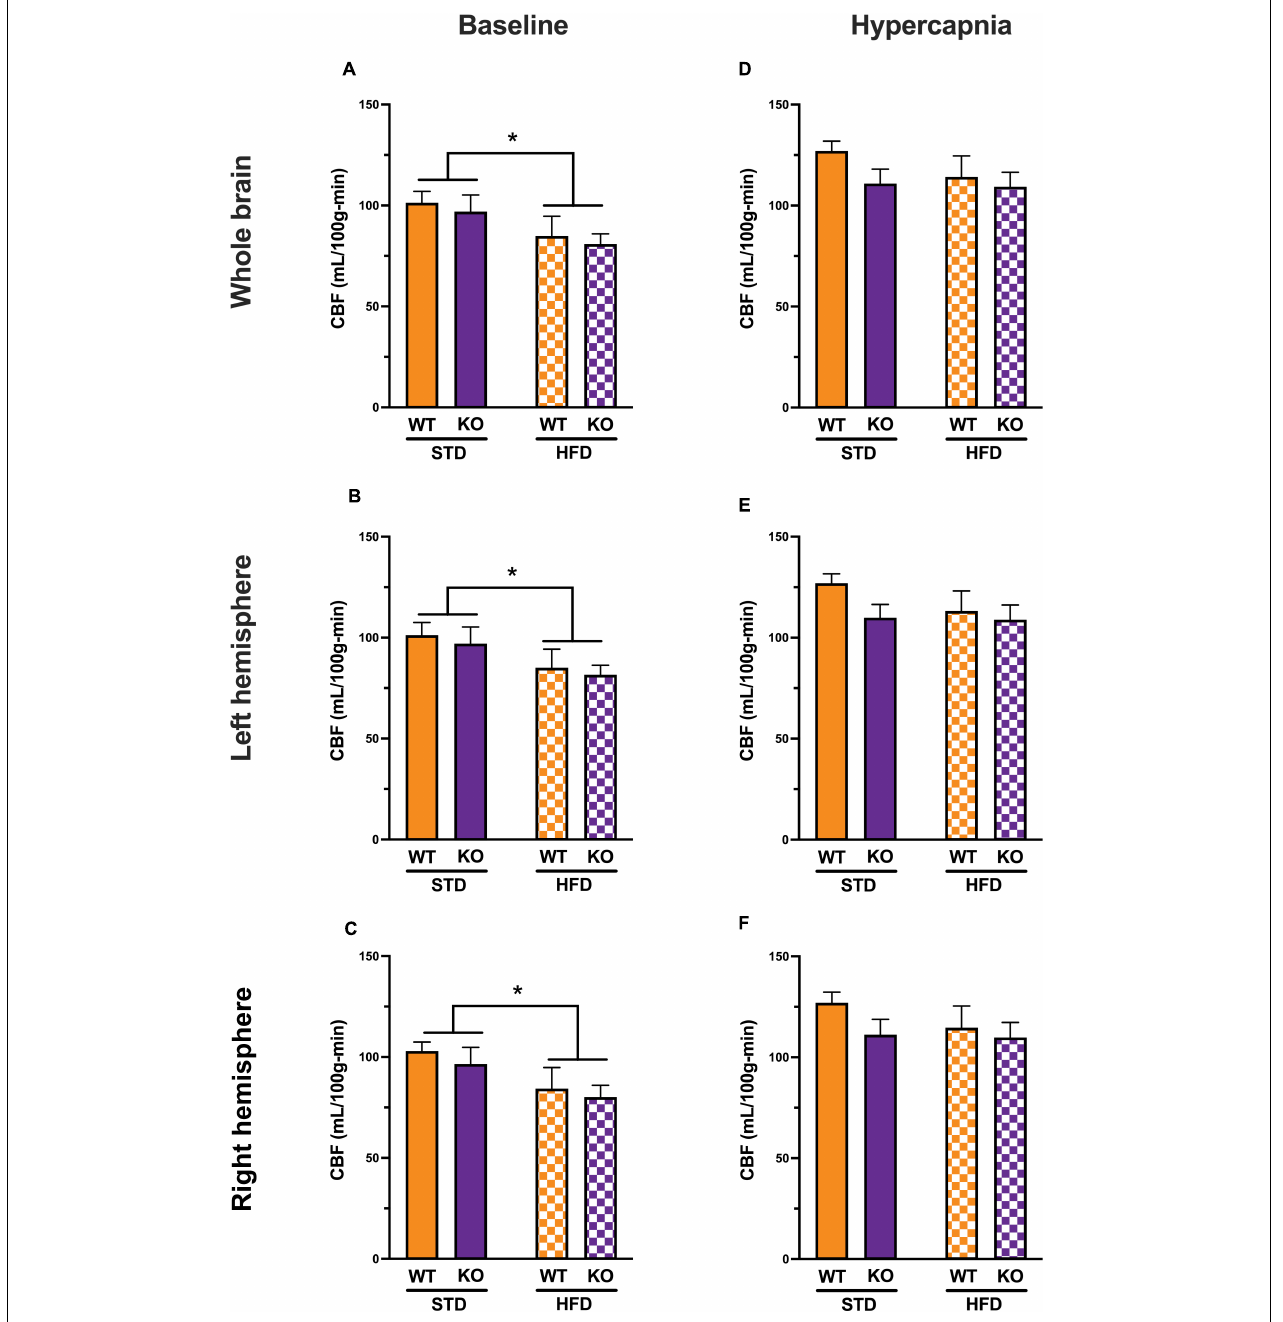
FIGURE 4 | Effects of GPR39 deficiency on cerebral blood flow. (A) At baseline, CBF (in ml/100 g/min) showed a diet effect between STD and HFD mice with lower CBF in HFD, but without genotype effect for the whole brain. (B,C) Left and right hemispheres showed a diet effect between STD and HFD mice with lower CBF in HFD, but without genotype effect. (D–F) With hypercapnia (CO 2 challenge), the absolute mean CBF increased in all groups with no diet or genotype effect for the whole brain and for both brain hemispheres. All values represent means ± standard error of the mean, * p < 0.05, n = 4–7 per group.